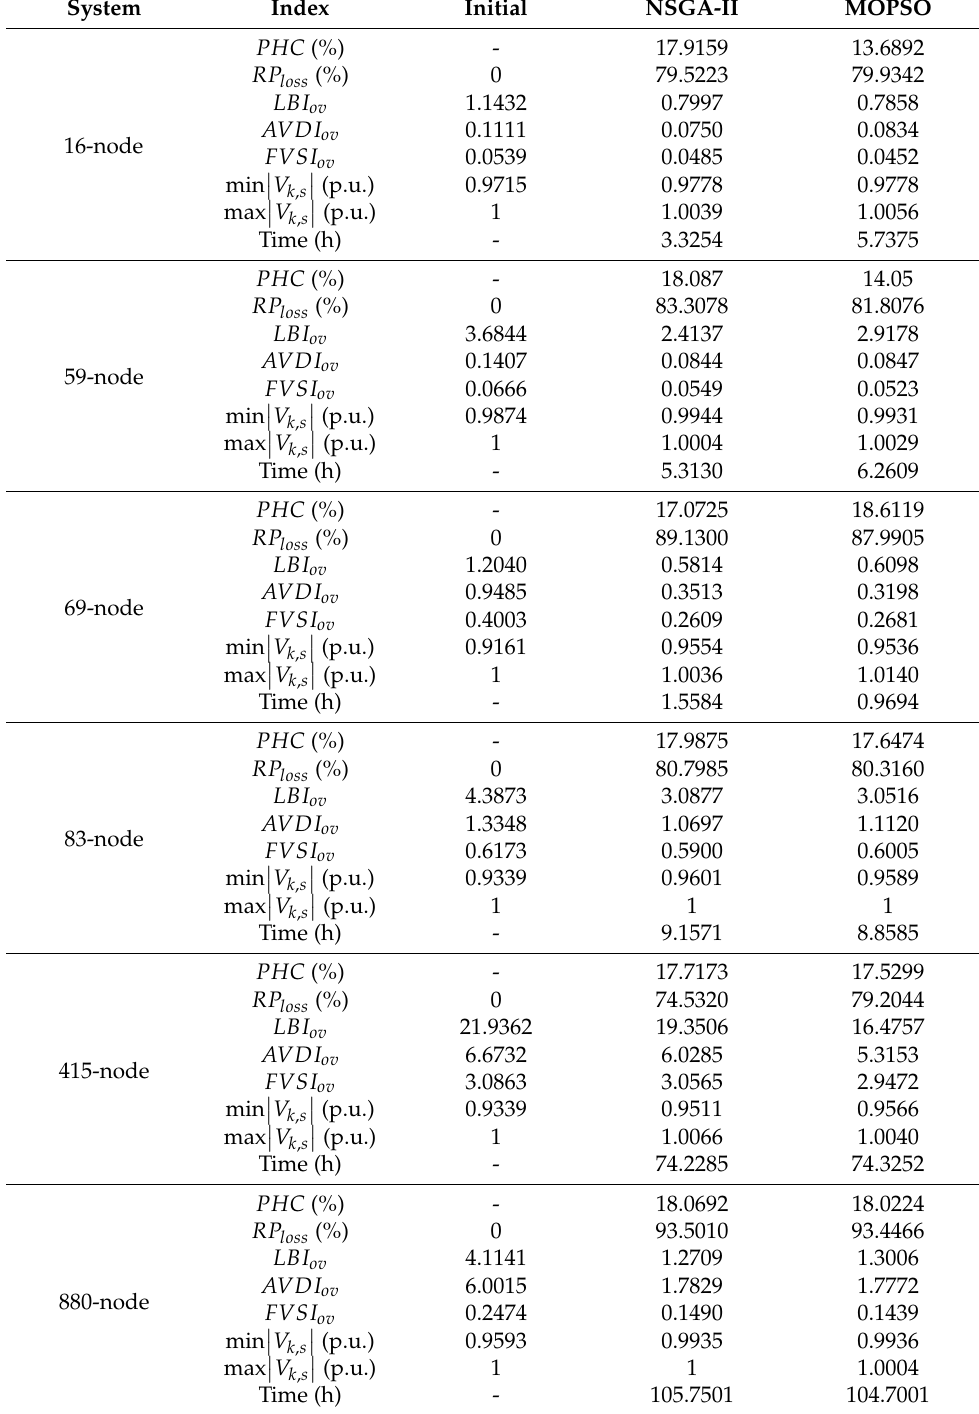
Table 5. Results for the studied distribution